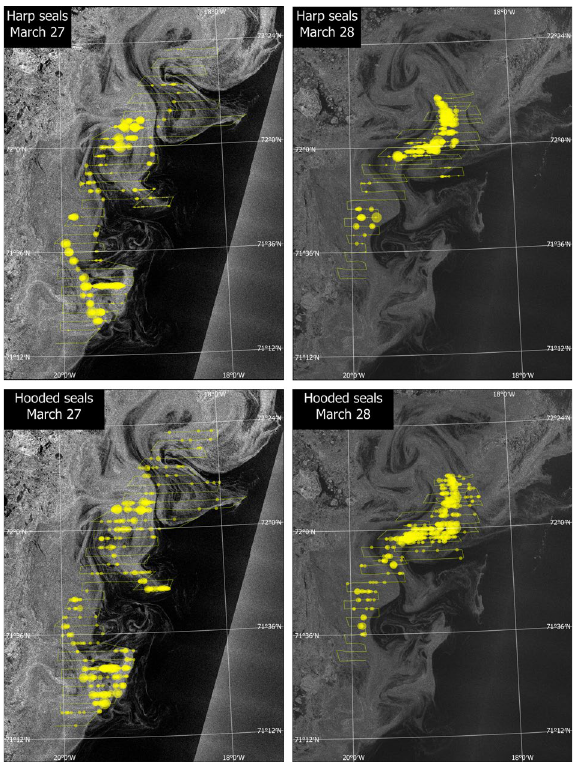
Figure 4. Photo surveys on March 27 and 28 overlaid on ice images. Each survey photography is represented by a yellow-filled circle with the radius proportional to the total number of harp and hooded seals counted on each